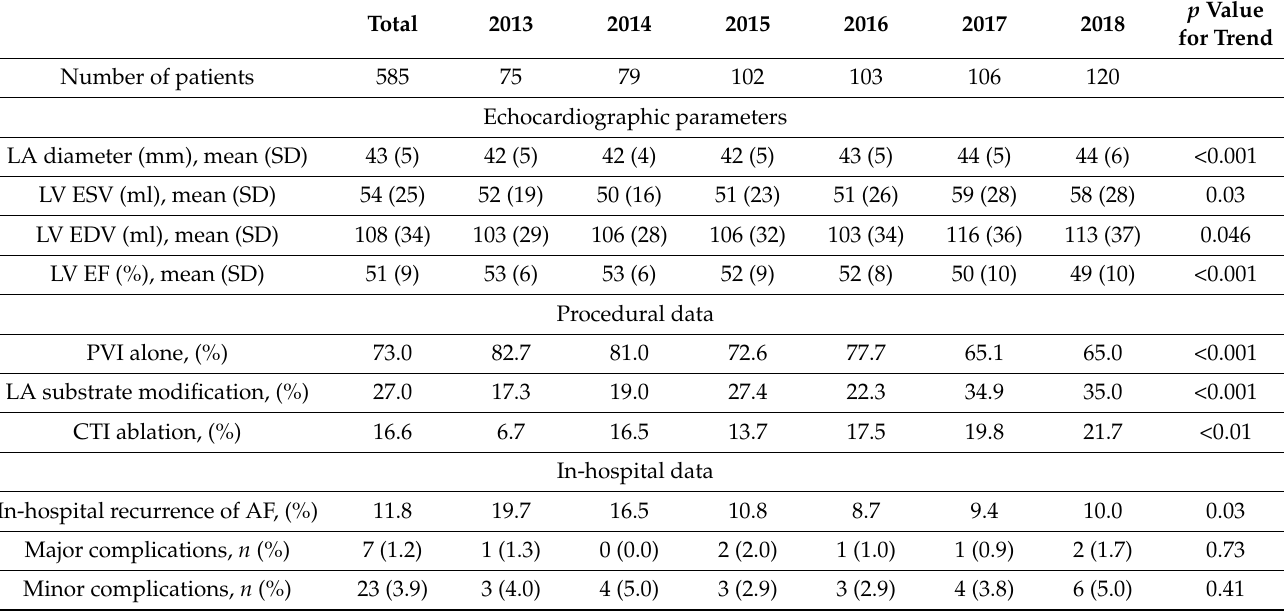
Table 2. In-hospital and periprocedural